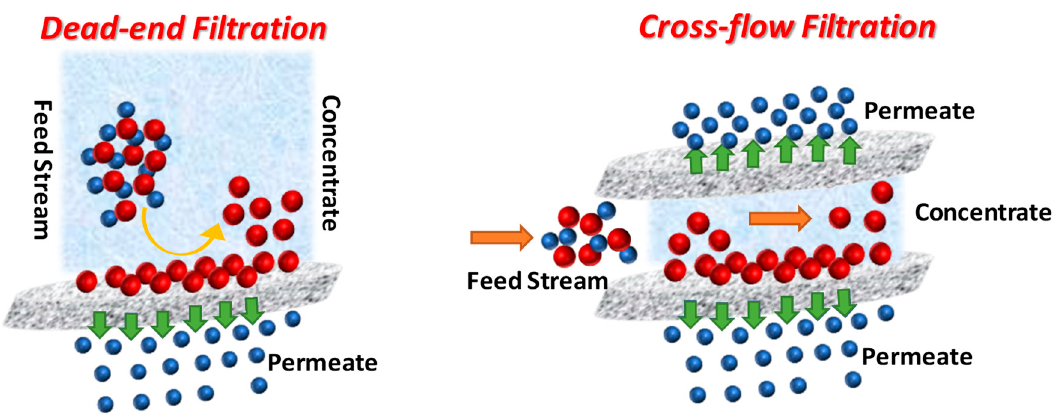
Molecules 2020 , 25 , x FOR PEER REVIEW Figure 3.